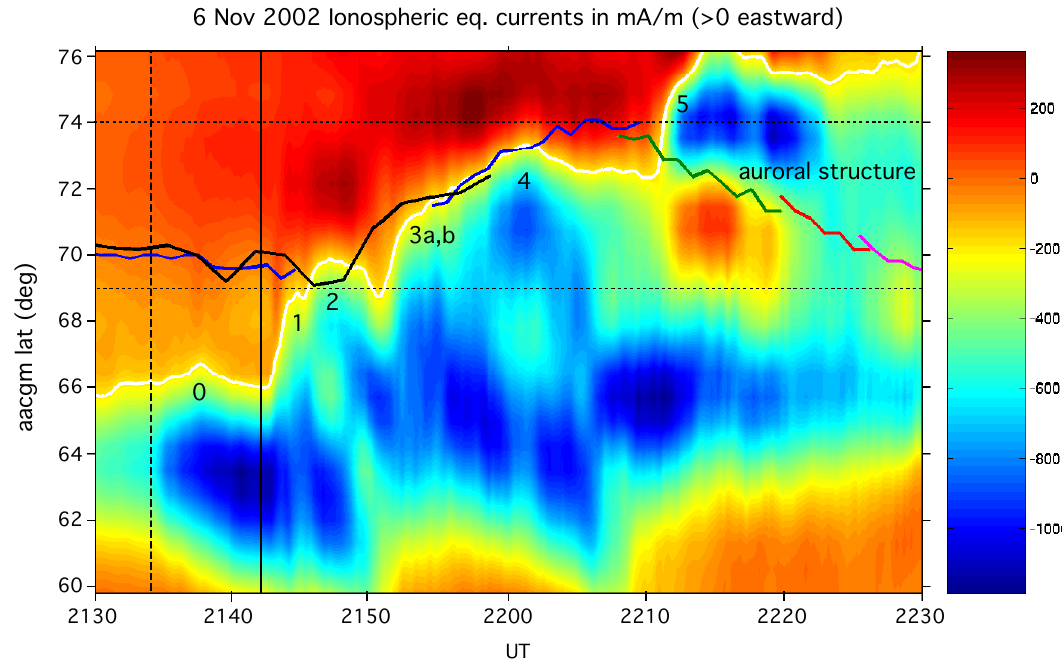
Fig. 8. Equivalent east-west current and the PCB during substorm in the same format as Fig. 7. Substorm intensifications are numbered and the location of the auroral structure is shown. For details, see text.